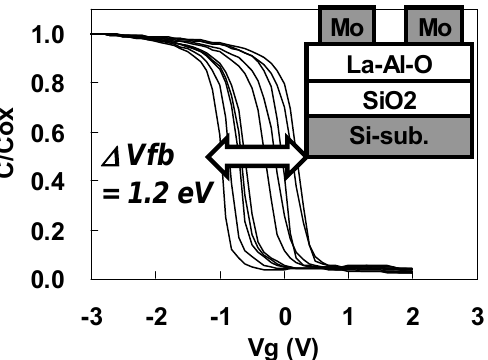
Figure 34. C-V curves for Mo/La-Al-O/SiO diameter over which the composition was